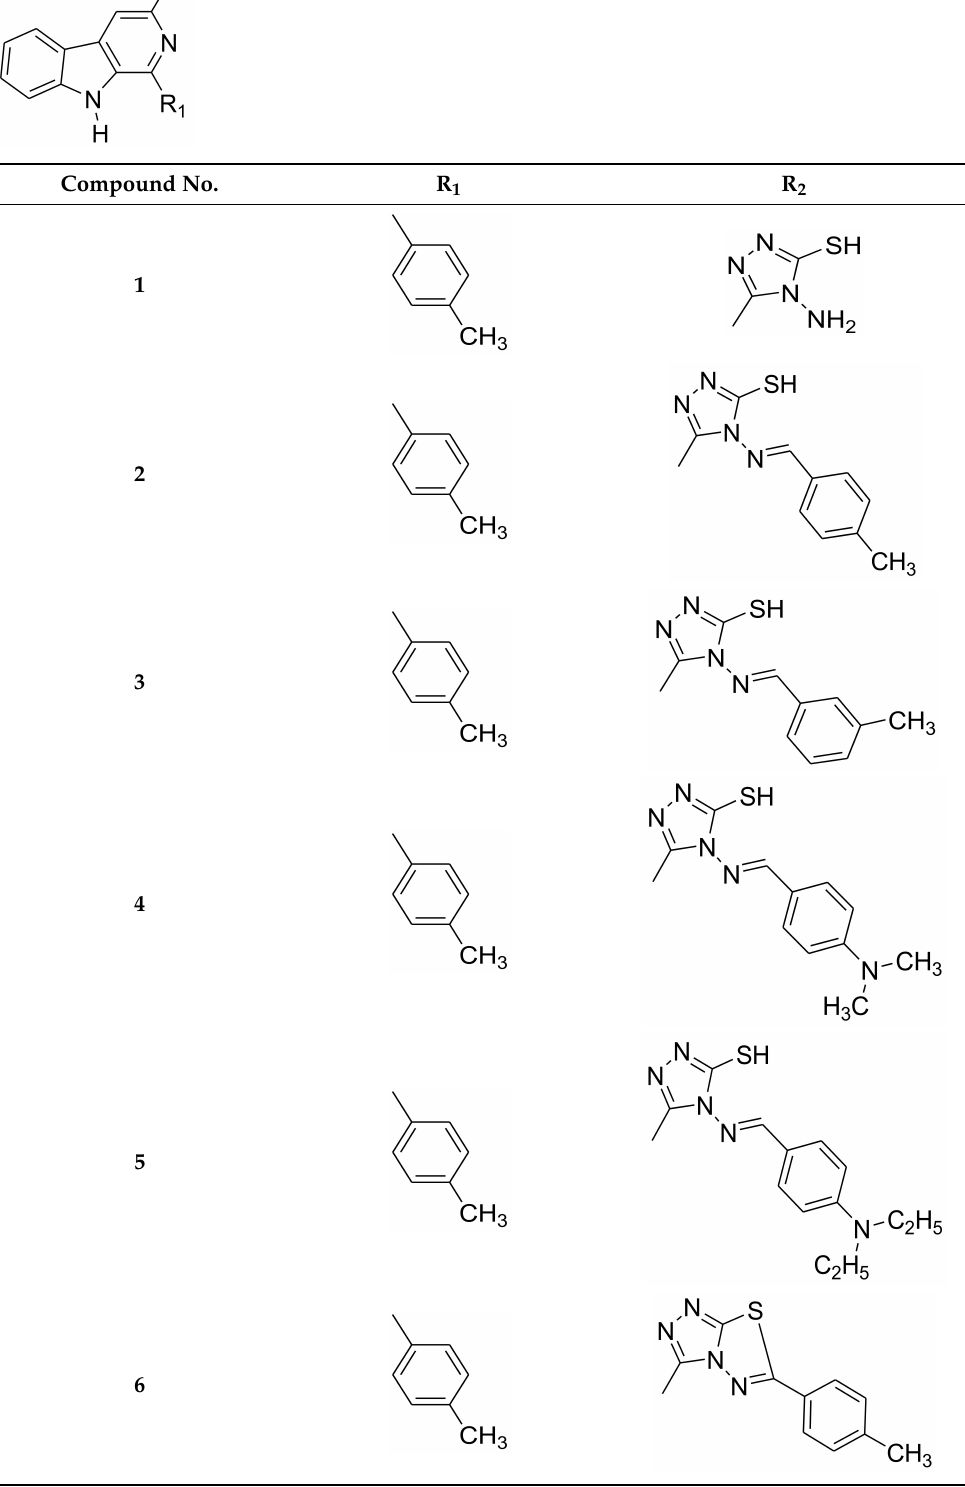
Table 1. Newly designed, substituted β -carboline